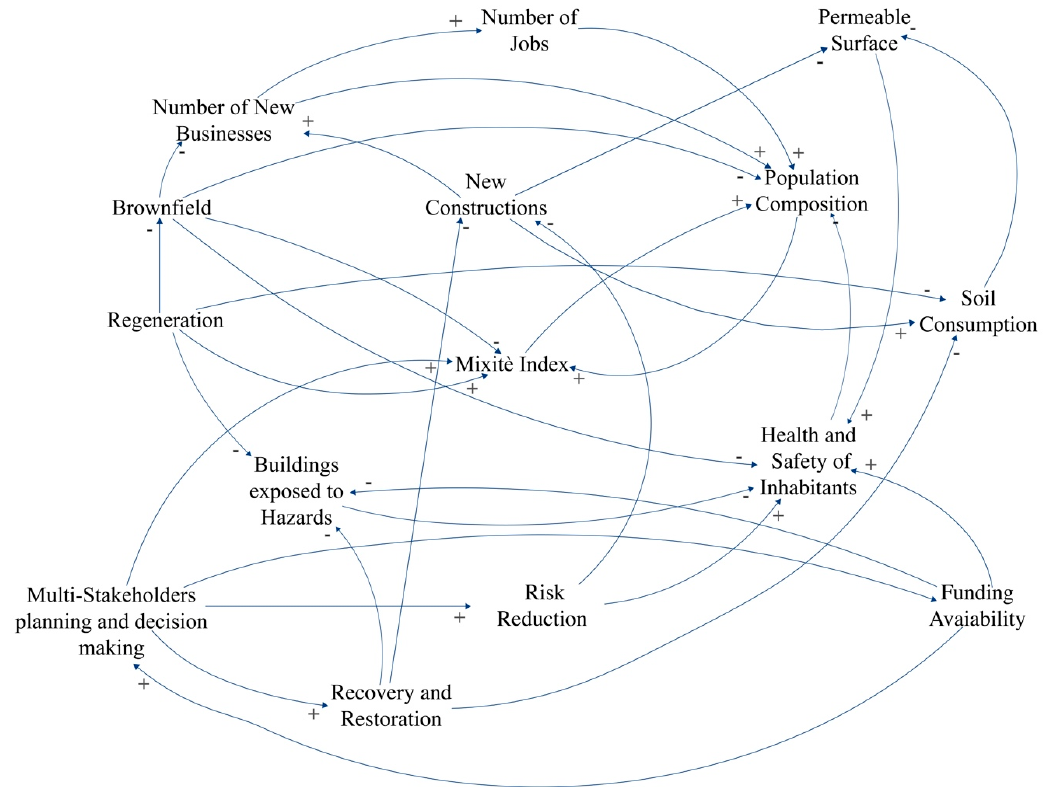
Figure 9. Causal loop diagram for Basse di Stura area (Datola et al., 2019) .